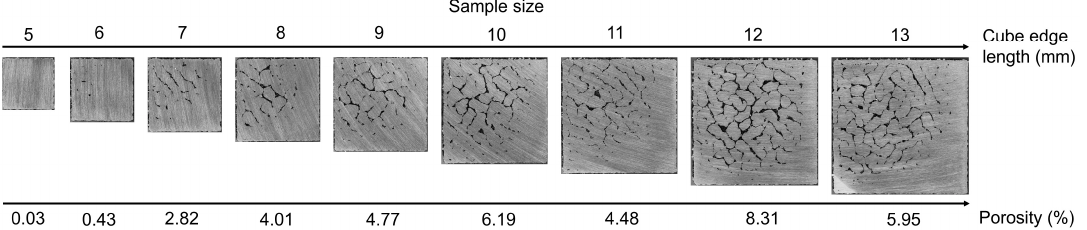
Figure 6. Metallography of different size cube samples fabricated using the meander strategy, top view of samples cross section (13 mm sample also shows the starting side and direction of scanning vectors in follow up layers, this was identical for all sample sizes) with relative density evaluated from the cross sections.